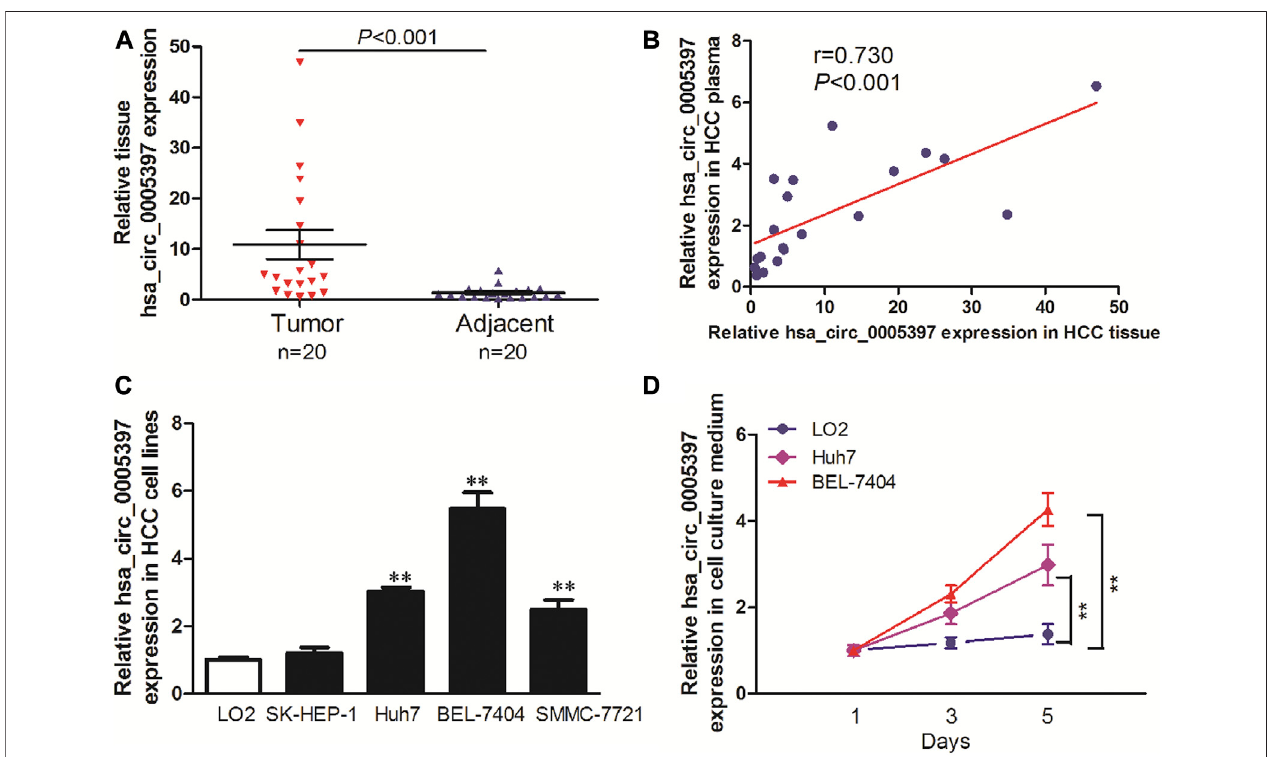
FIGURE4| Theoriginofcirculatinghsa_circ_0005397. (A) Theexpressionlevelsofhsa_circ_0005397inHCCtissuesandcorrespondingadjacentnormaltissues. (B) The correlation between plasma hsa_circ_0005397 expression levels and tissue hsa_circ_0005397 expression levels. (C) The expression levels of hsa_circ_0005397 in 4 HCC cell lines. (D) Hsa_circ_0005397 was released from tumor cells into the cell culture medium in a time-dependent manner, ** p <